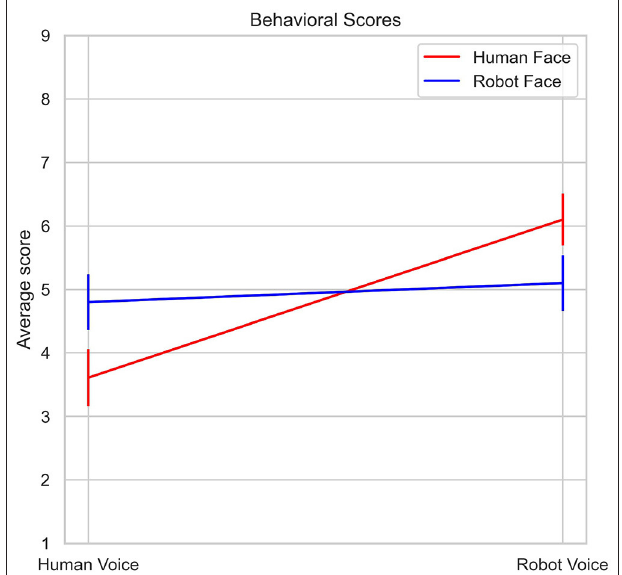
FIGURE 4 | Changes in average Uncanniness score with respect to voice type and face